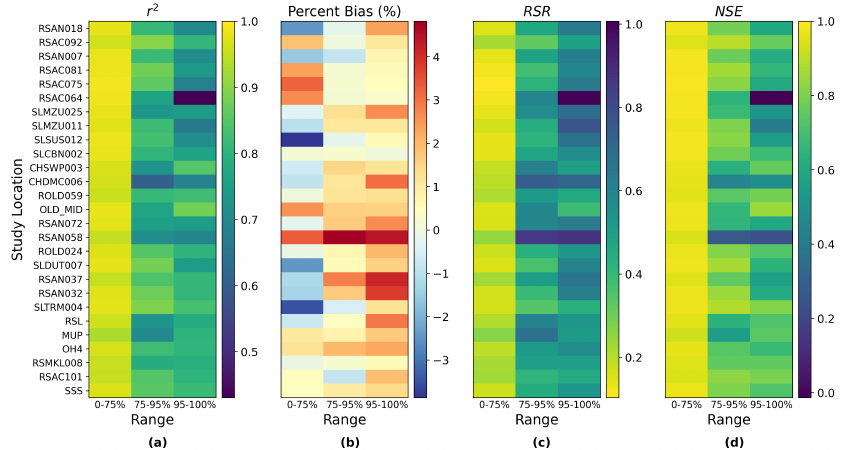
Figure A2. Model (ungrouped MLP) performance measured by ( a ) r 2 , ( b ) Percent Bias, ( c ) RSR, and ( d ) NSE at different salinity ranges: low-middle range (lowest 75%), high range (75 to 95 percentile), and extreme high range (highest 5%) at the study